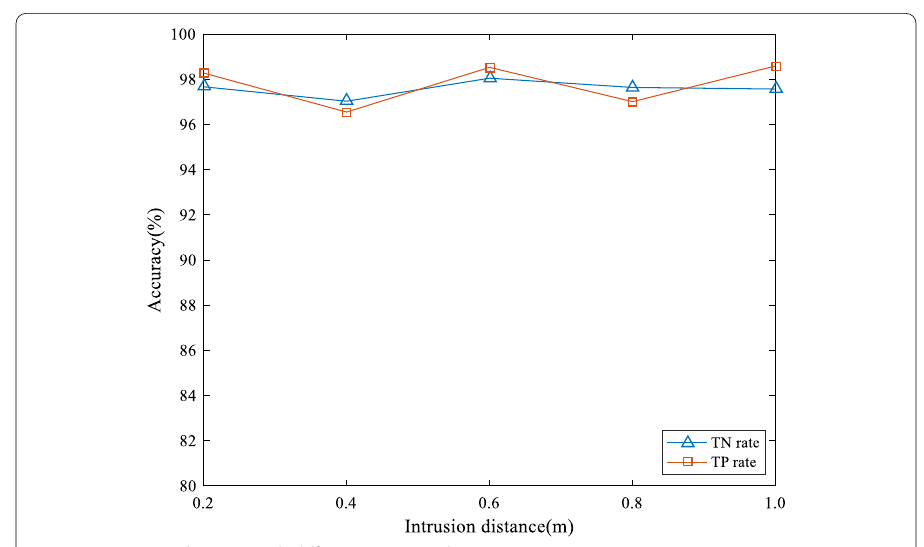
Fig. 15 TN rate and TP rate with different intrusion